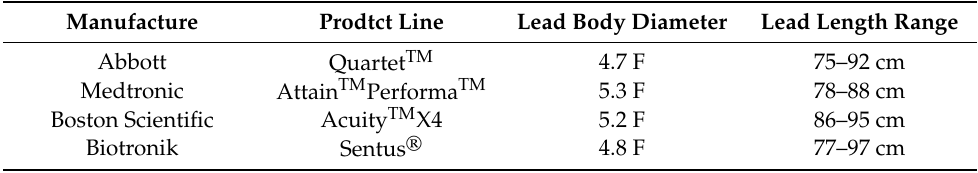
Table 1. Cardiac venous (LV) leads